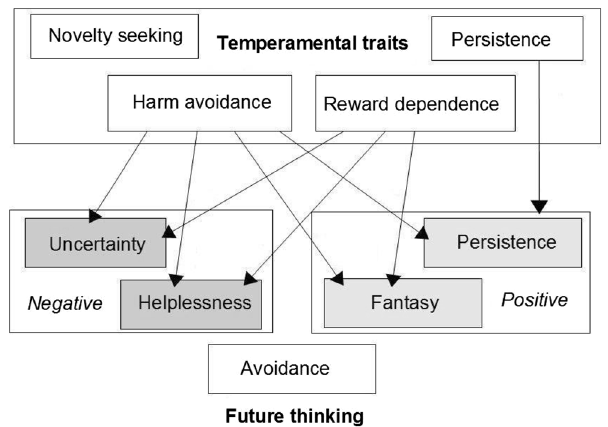
Fig. 2 Graphical linear regression analysis between temperament and future-thinking